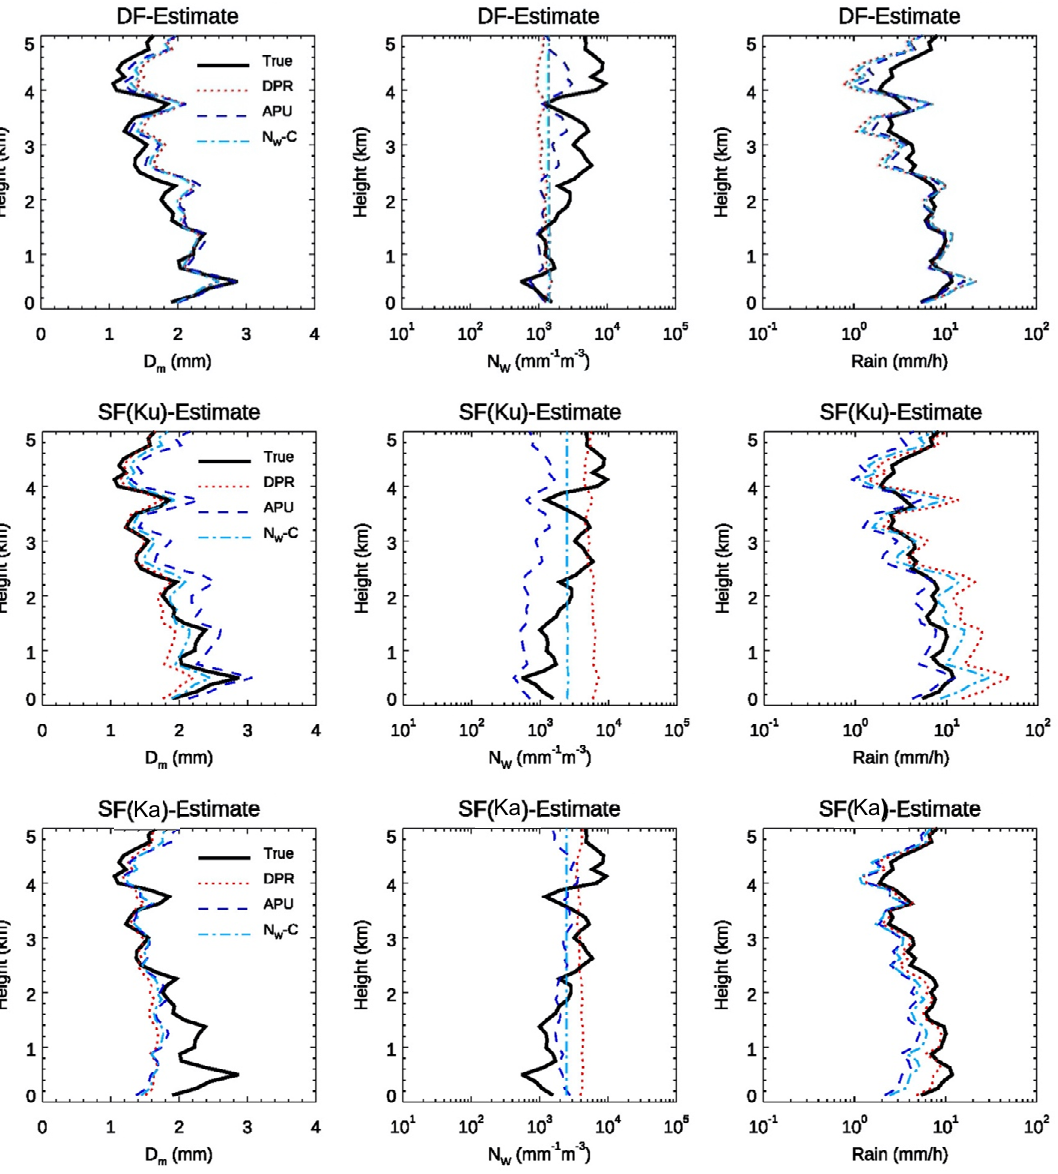
Figure 2. Comparisons of the profiles of D m ( left column), N w ( middle column), and R ( right column) estimated from the DF ( top row), Ku- ( middle row), and Ka-band ( bottom row) SF algorithms, with their respective true values (thick solid black curves) that are directly computed from the DSD profiles. The estimates are made with use of several R-D m relations including the DPR-default relation (denoted by DPR), the R-Dm relation obtained from the Parsivel DSD data (denoted by APU), and the one derived from the gamma DSD model (N w -C).